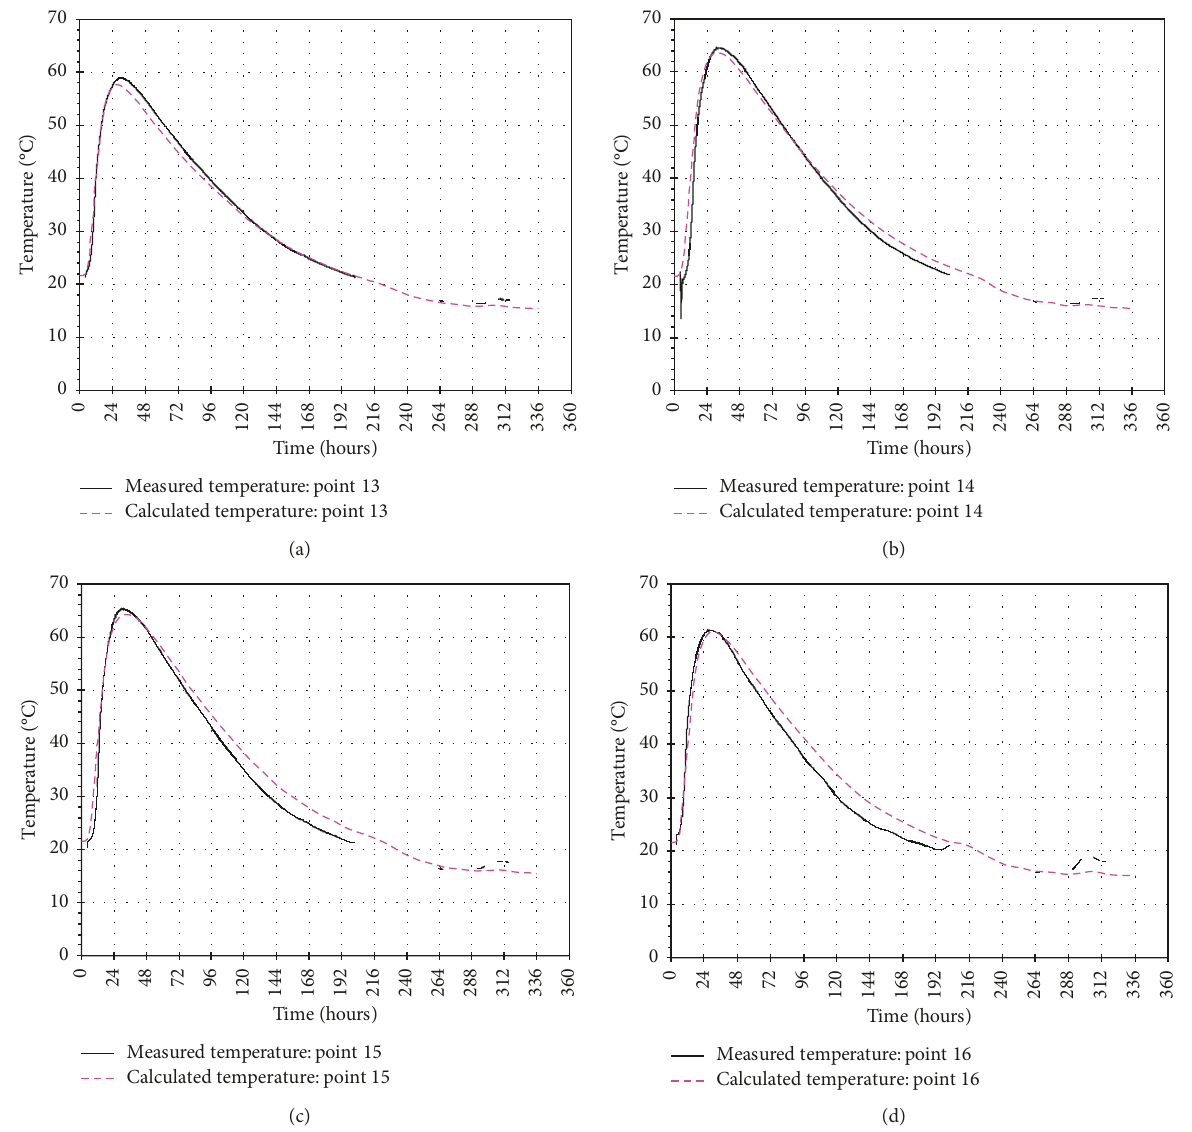
Figure 10: Calculated and measured temperatures in the middle section